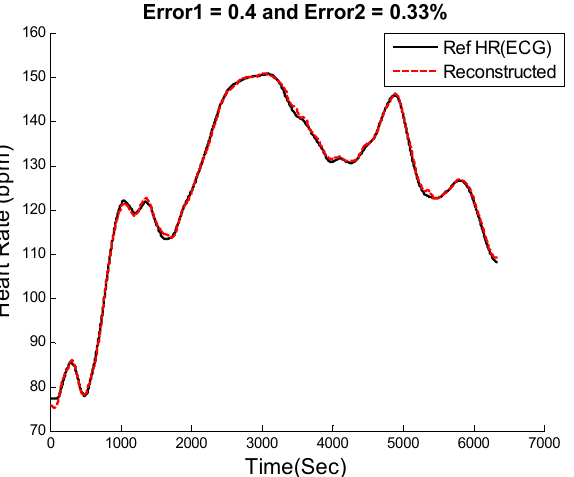
Figure 5. Comparison of reconstructed HR obtained from SpaMA to reference HR obtained from simultaneous ECG recordings.